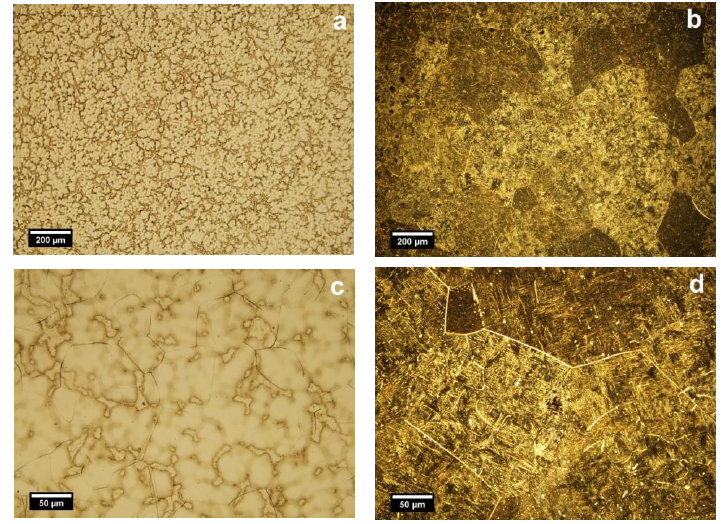
Figure 1. Optical microstructures of cast ( a , c ) and annealed ( b , d ) Ti25Nb10Zr alloy: α (light) and β (dark) phases. Etched state, light microscope.